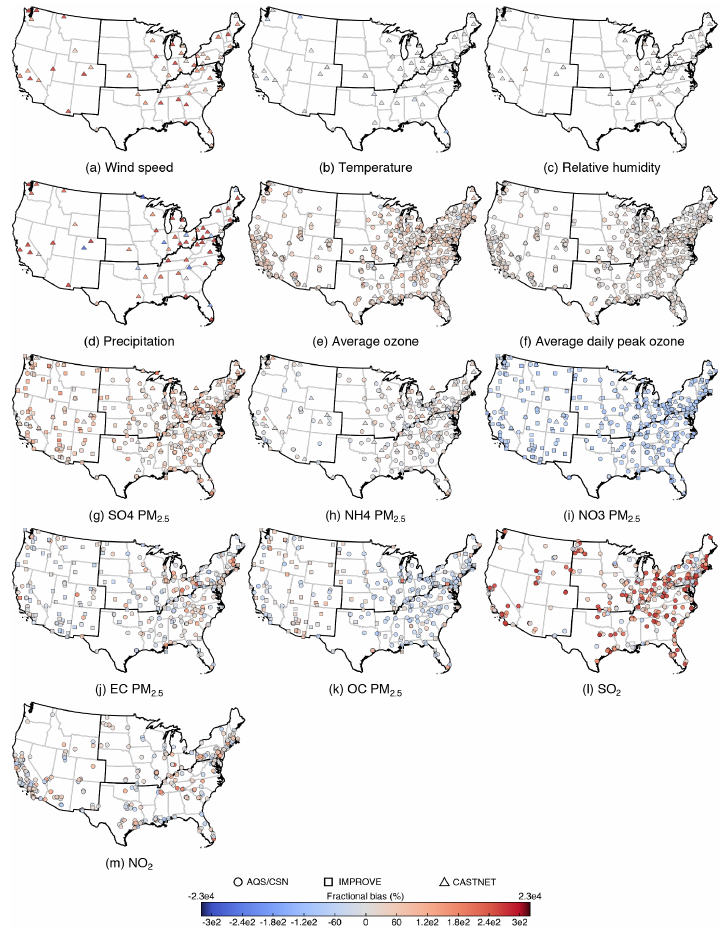
Figure A1. AQS, CSN, IMPROVE AQS and CASTNET monitor locations and annual average fractional bias for (a – d) meteorological variables and (e – m) pollutant